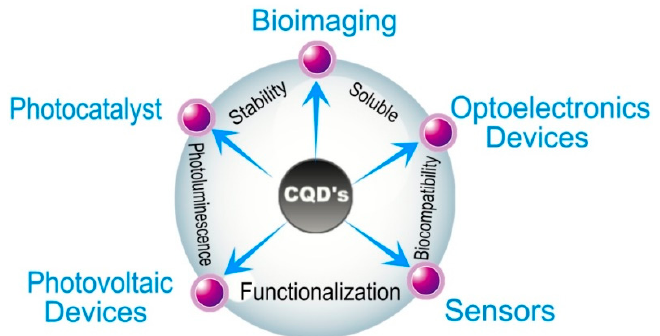
Figure 1. Main properties and applications of CQDs in the Organic Electronics field. The figure was drawn based on the model stated on the Reference [7].